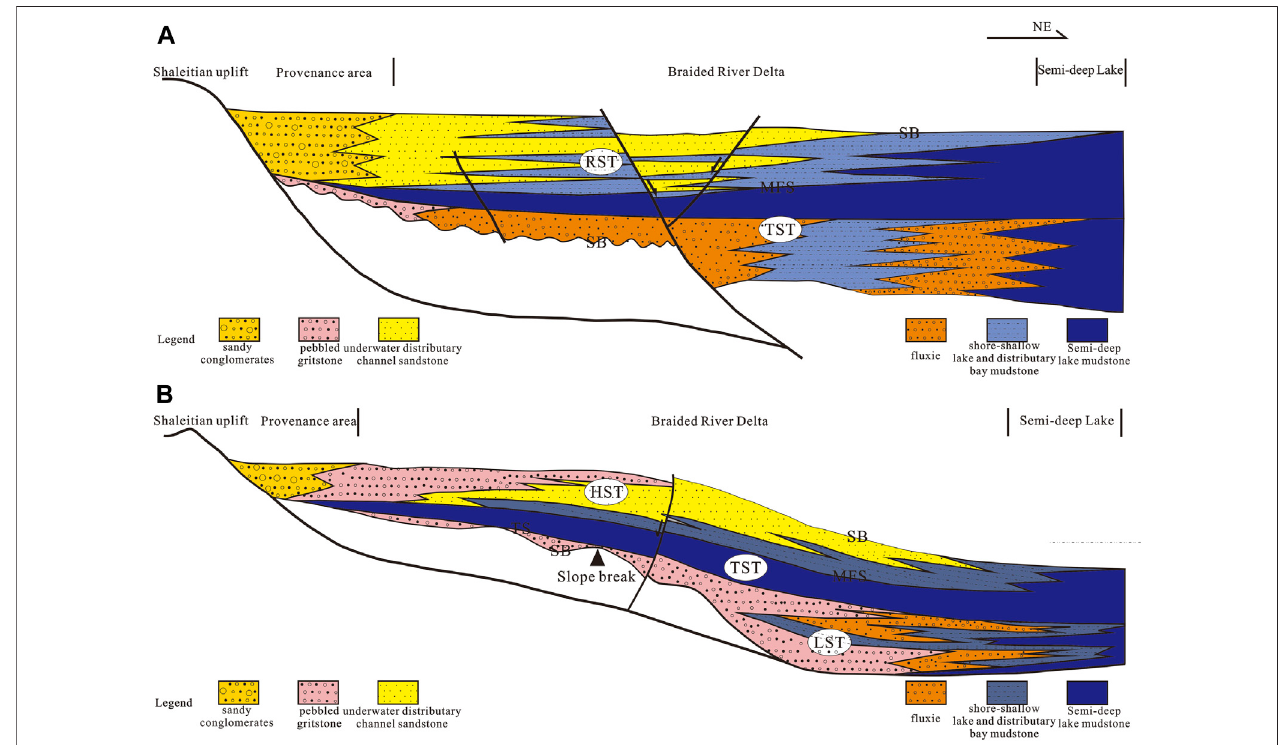
FIGURE7| Sedimentary fi llingmodel ofthemiddle and deepstrata intheNanpu No. 3structural area. (A) Sequence sedimentary fi llingmodel withoutslope break zone (SW to NE); (B) Sequence sedimentary fi lling model with slope break zone (SW to NE).